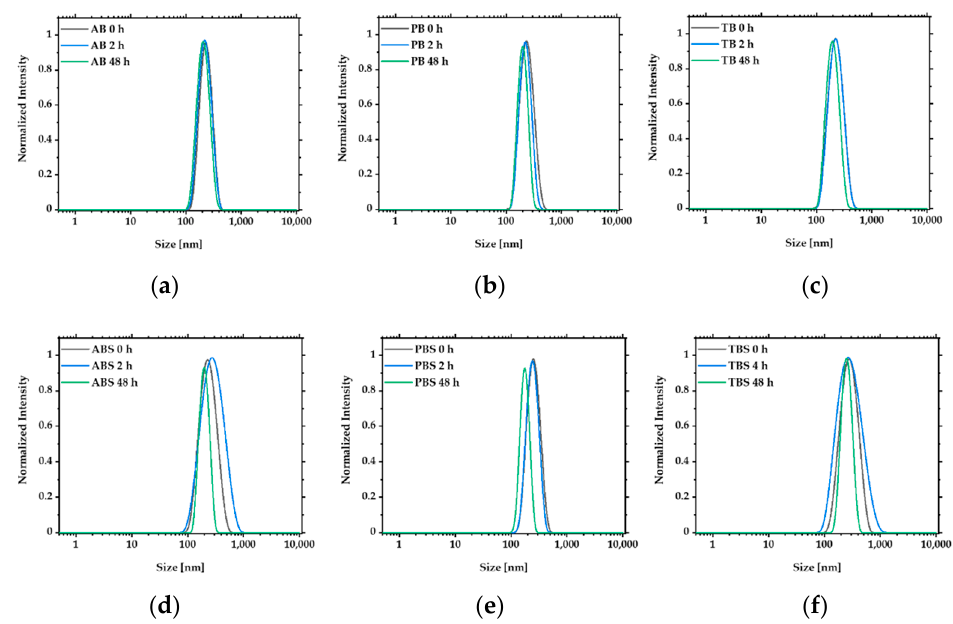
Figure 2. Stability studies of NGs in different buffer solutions measured by DLS. NGs were incubated at 37 °C in three different buffer solutions (10 mM) with and without saline (140 mM) for 48 h. ( a ) pH 4.5 acetate buffer (AB); ( b ) pH 7.4 phosphate buffer (PB); ( c ) pH 8.1 Tris buffer (TB); ( d ) pH 4.5 acetate-buffered saline (ABS); ( e ) pH 7.4 phosphate-buffered saline (PBS); ( f ) pH 8.1 tris-buffered saline (TBS).